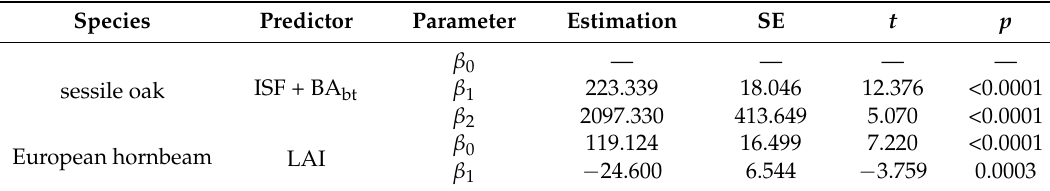
Table 8. The estimated parameters of the new sprouts height